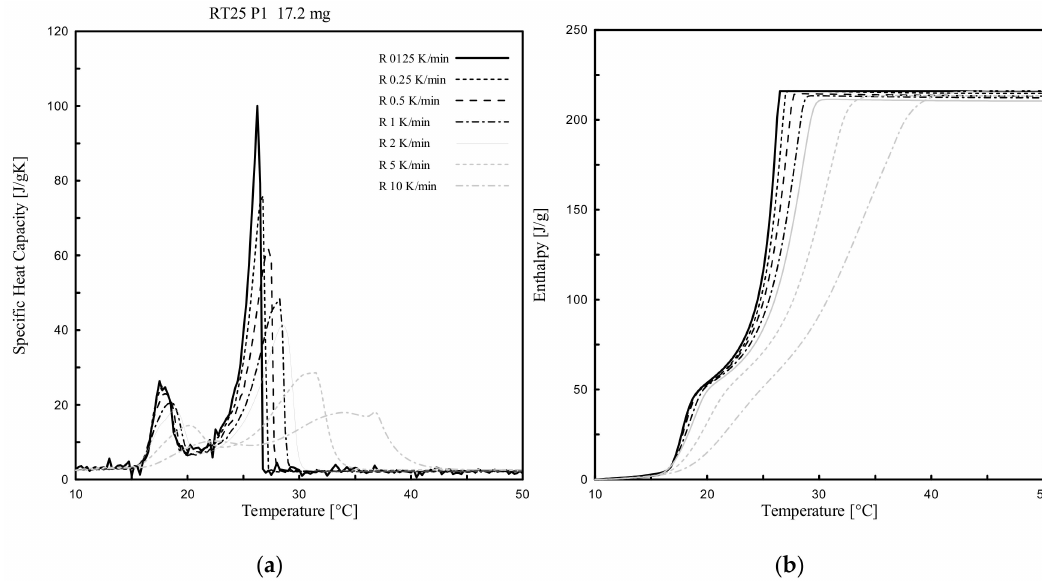
Figure 6. Dynamic DSC measurements: ( a ) c p (T) and ( b ) h(T) curves (latent only) with di ff erent heating rates for RT25.